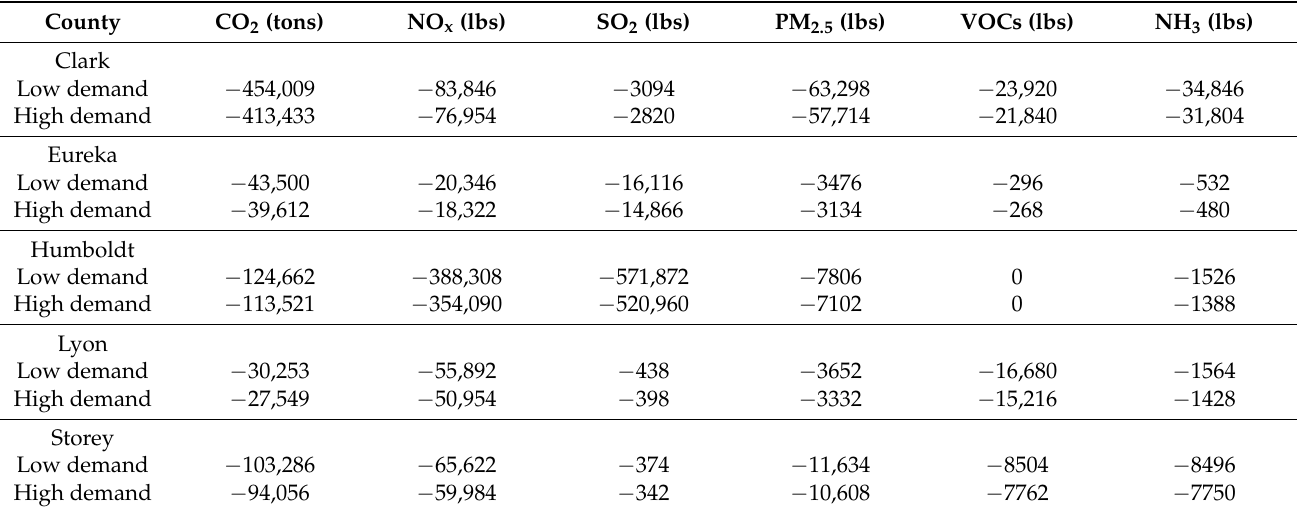
Table 3. County-level emission changes in Nevada from the 2019 baseline, upon RPS 50% and under the low- or high-demand scenario by